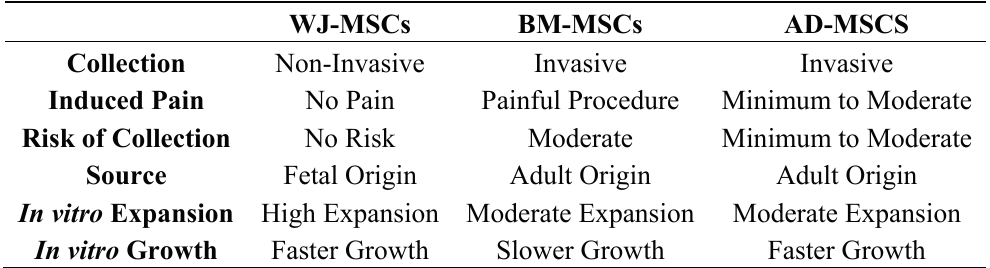
Table 2. Comparison of WJ- MSC features with other